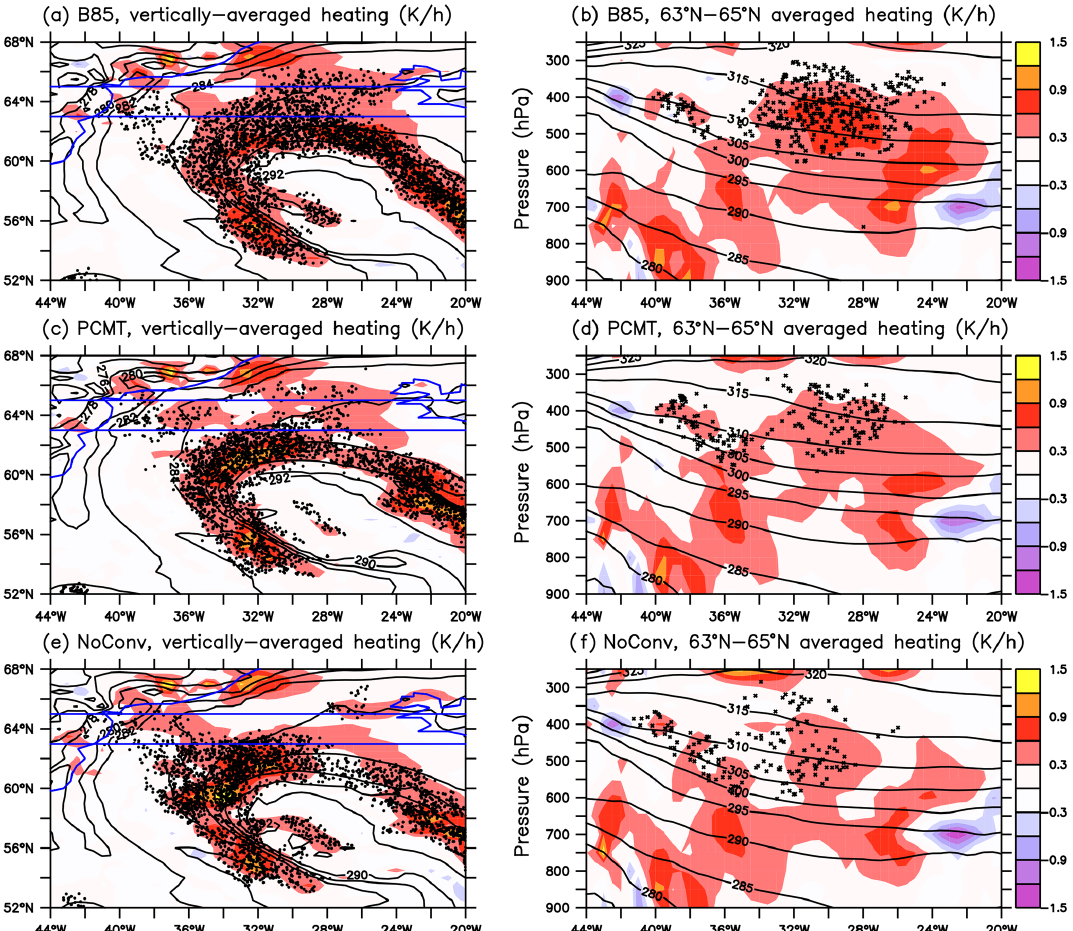
Figure 6. (a, c, e) Vertically averaged heating rate between 300 and 800hPa (shadings; units: Kh − 1 ), potential temperature at 850hPa (inter- val: 2K) and WCB trajectories satisfying 25hPa ascent in 2h at 12:00UTC on 2 October for (a) B85, (c) PCMT and (e) NoConv simulations. (b, d, f) Latitudinally averaged (63–65 ◦ N; see blue lines in panels a, c and e ) heating rate (shadings; units: Kh − 1 ), potential temperature (contours; interval: 5K) and WCB trajectories satisfying 25hPa ascent in 2h and located in the same latitudinal band at 12:00UTC on 2 October for (b) B85, (d) PCMT and (f) NoConv